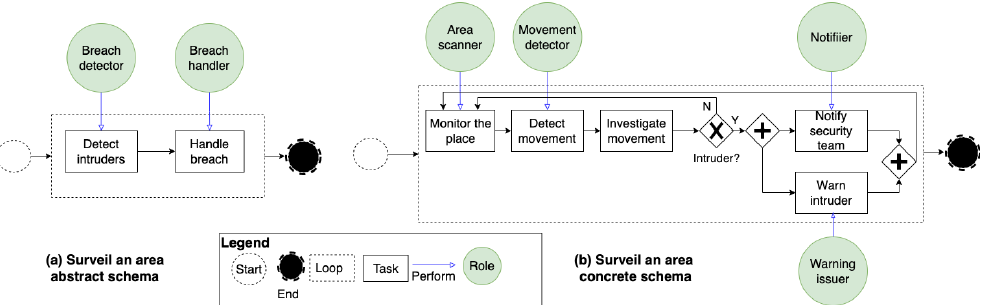
Figure 3. Role-based schemas that can be instantiated to surveil a